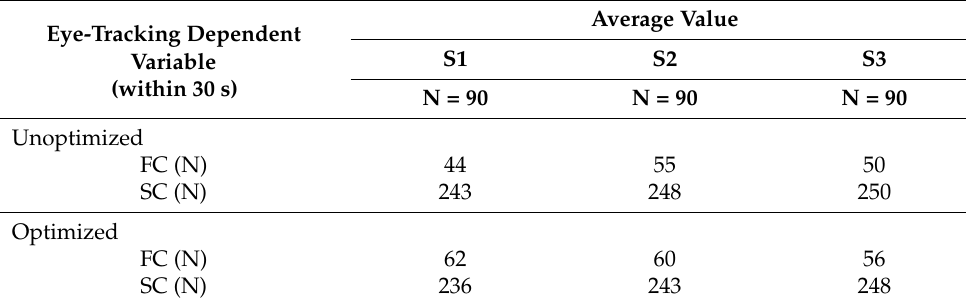
Table 11. Comparison of Eye-Tracking Index Data before and after